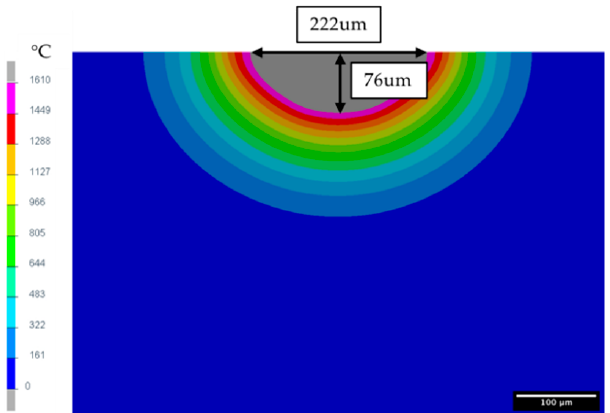
Figure 7. Cross-section of 82 W spot-melt scenario, showing maximum temperature contours pre- dicted by SYSWELD and resulting maximum melt pool depth and width. Note: grey area shows predicted area that is above 1610 °C, the approximate liquidus temperature.